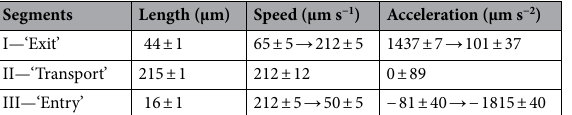
Table 1. The motion of the trapped polystyrene bead along the side ‘a’ of the optical triangle.